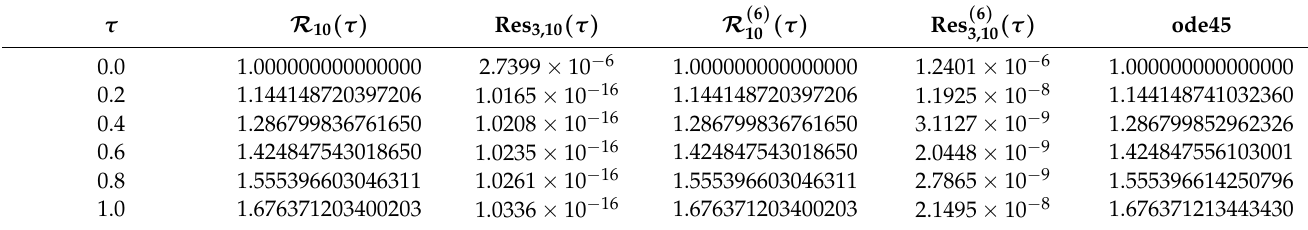
Table 3. The comparison of numerical results for in Test Case